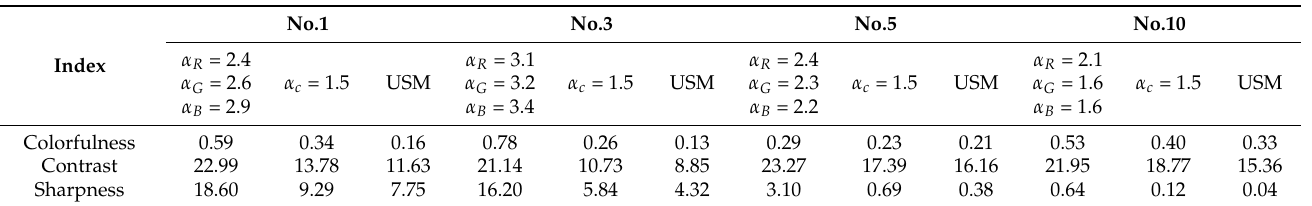
Table 3. Objective evaluation values of the four Gaussian images after the adaptive color adjustment at different α c values and the USM sharpening.